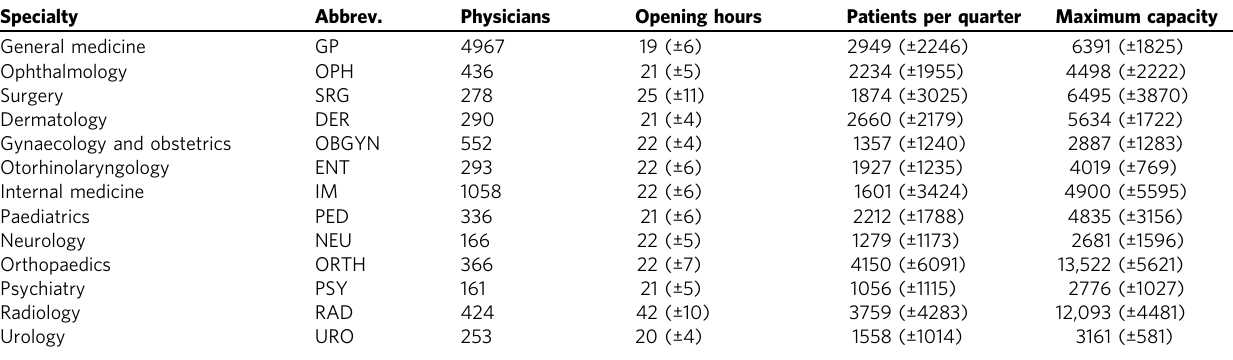
Table 1 Descriptive table of medical specialties and their basic characteristics.